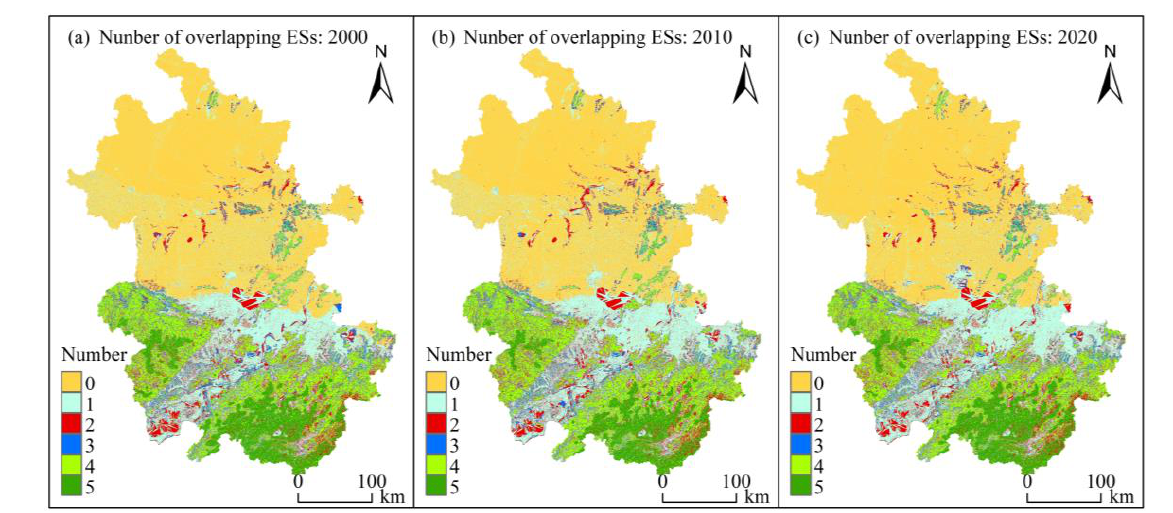
Figure 8. Overlap of different ES hotspots.